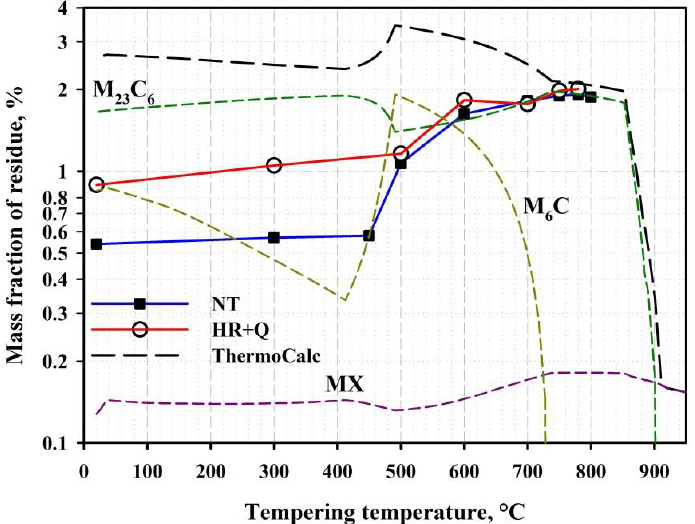
Figure 9. Mass fractions of the extracted precipitate residues as a function of tempering temperature.